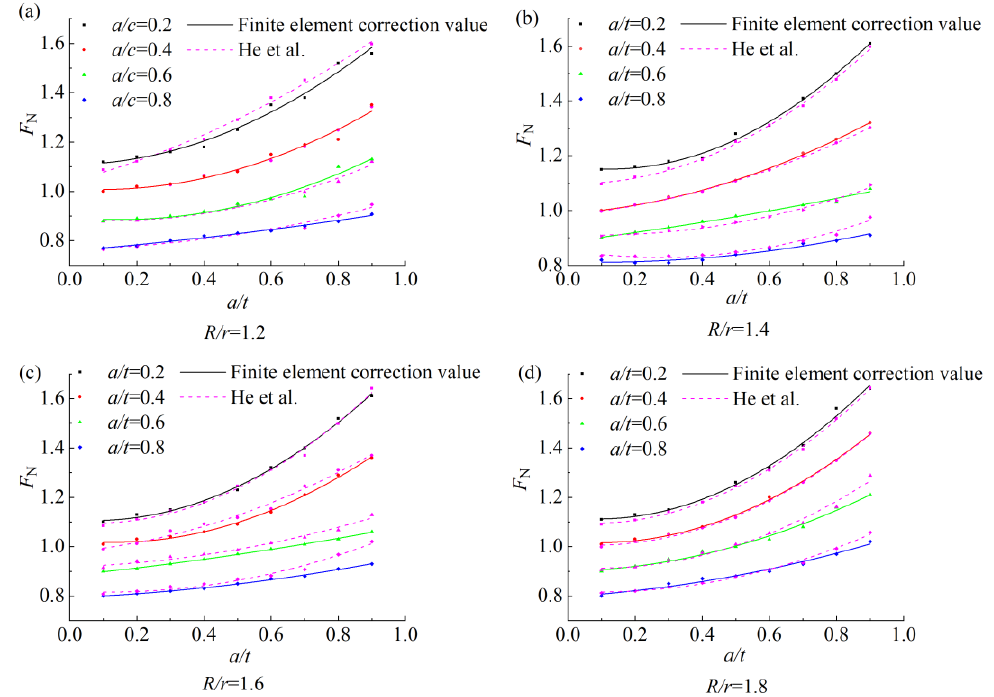
Figure 10. Comparison of corrected shape coefficients without a V-shaped notch F N obtained by the FEM in this paper and in the literature. ( a ) R / r = 1.2. ( b ) R / r = 1.4. ( c ) R / r = 1.6. ( d ) R / r = 1.8.